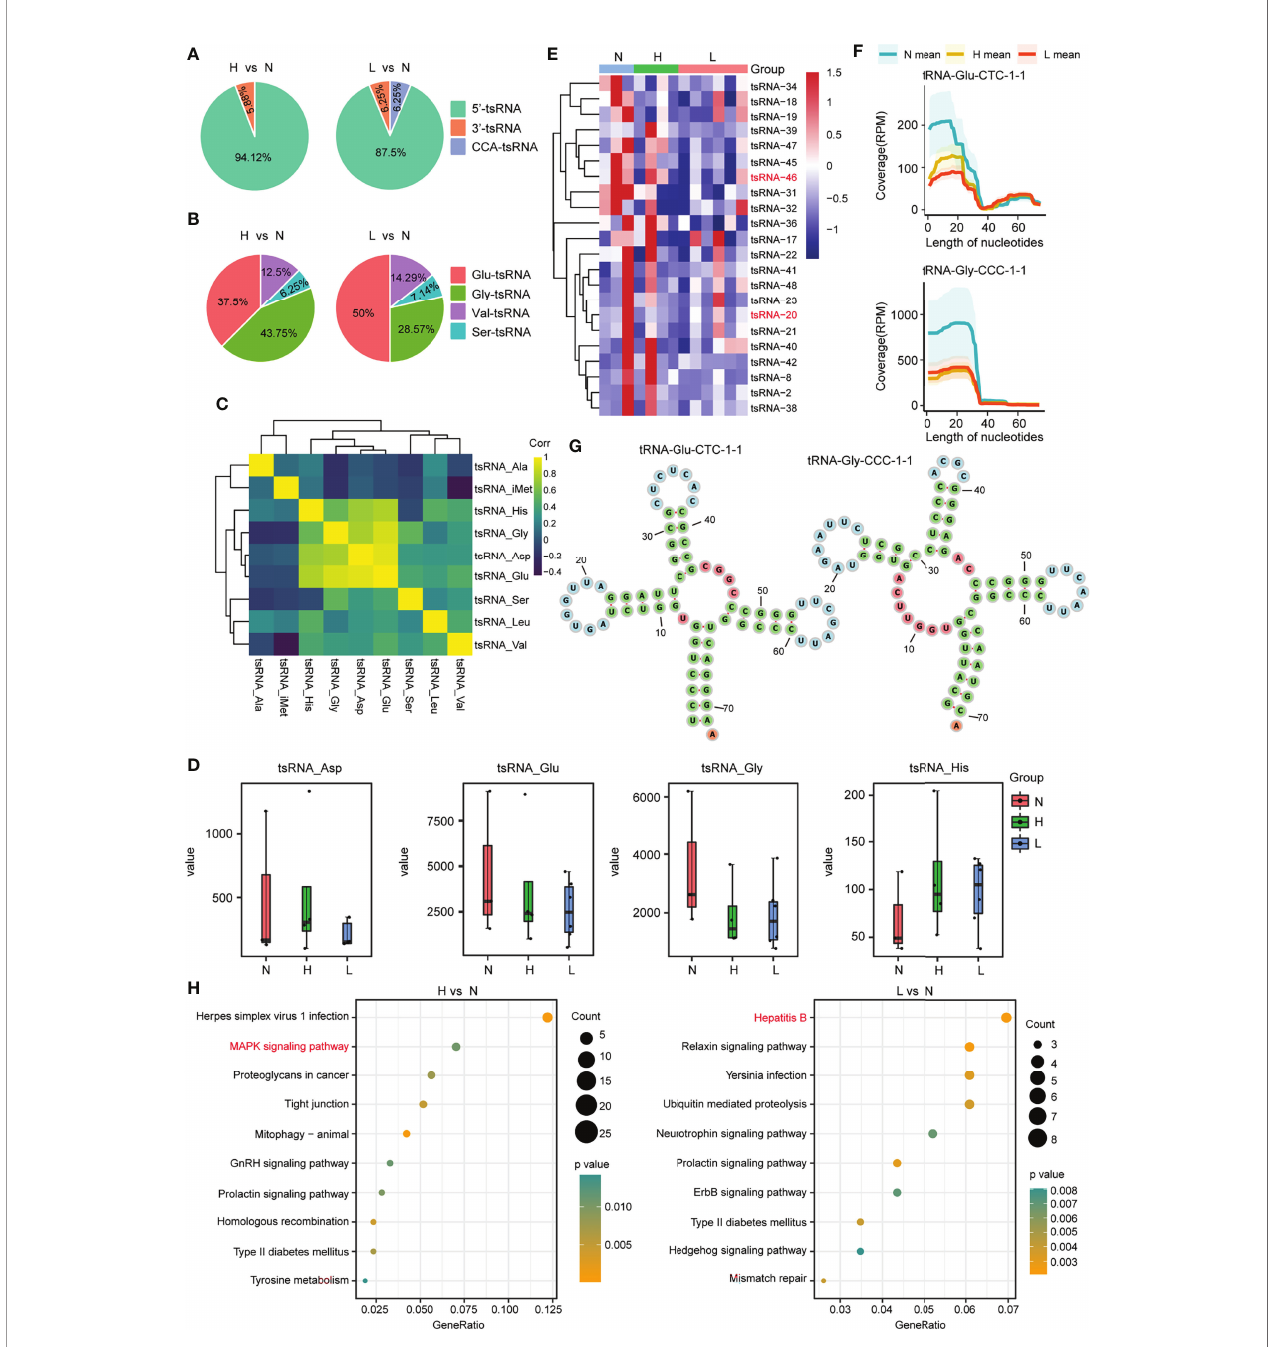
FIGURE 3 | tsRNA differential expression analysis within plasma exosomes. (A) Percentage of each type of tsRNAs in the above two comparison groups. (B) Percentage of 5 ′ -tsRNAs generated from Glu-, Gly-, Val-, and Ser-tRNA. (C) tsRNA coexpression patterns among plasma exosomes from the discovery set. Spearman ’ s rank correlation coef fi cient. tsRNA-Gly, tsRNA-His, tsRNA-Glu, and tsRNA-Asp showed strong and positive relation mutually. (D) Expression pro fi les for tsRNA-Glu, tsRNA-Asp, tsRNA-His, and tsRNA-Gly among the N, H, and L subjects. (E) Heatmap showing differential tsRNA expression among L, N, and H sets. (F) The coverage pro fi le of the plasma exosomal tsRNA-20 and tsRNA-46 sequences along tRNA-Gly-CCC-1-1 and tRNA-Glu-CTC-1-1, respectively. Solid curves presenting average RPM of N, H, and L groups. RPM, reads per million; nt, nucleotide. Colored band stood for 95% CI. tsRNA-20 and tsRNA-46 sequences were obtained in tRNA 5 ′ -terminal. (G) The tRNA secondary structure revealed the representative individual tsRNA. (H) The KEGG pathway analysis for the differentially expressed tsRNAs in the above two comparison